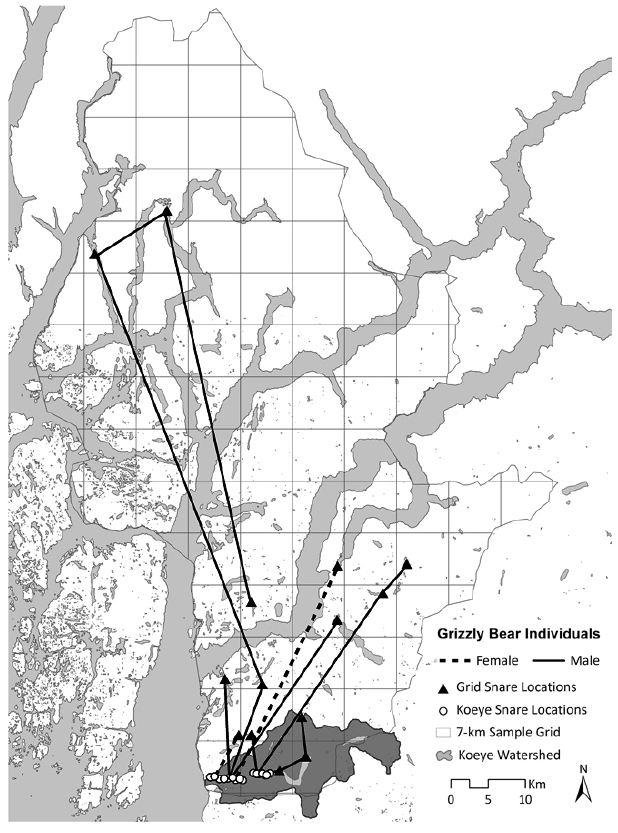
Fig. 5 . Location of hair snare stations where individual grizzly bears ( Ursus arctos horribilis ) were originally identified in Koeye watershed during this study (circles) and then recaptured during independent spring grid-based sampling (triangles) on a large spatial scale in Heiltsuk Territory (British Columbia, Canada). Lines represent minimum distances traveled between snares by female (dashed) and male (solid) bears. Grids were 7 km, snares placed in suitable habitat within each grid cell, established in spring 2010 (see